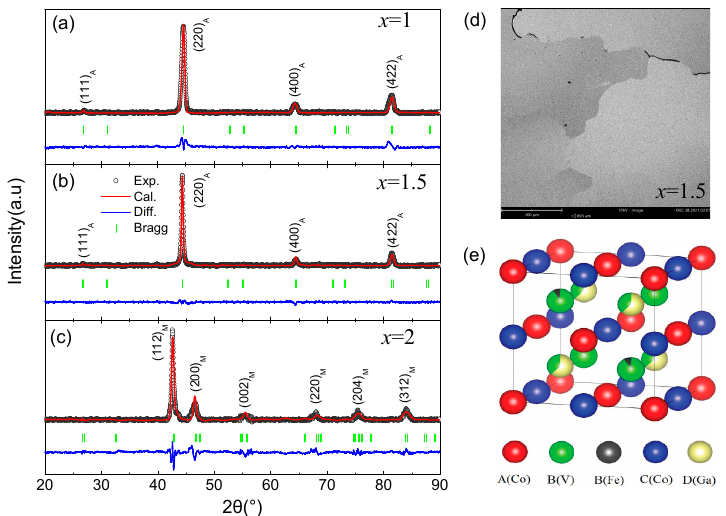
Figure 1. ( a – c ) The X-ray diffraction patterns of Co 50 V 34 Ga 16- x Fe x alloys at room temperature. ( d ) The micrograph taken by SEM for the sample with x = 1.5. ( e ) The L 2 1 -type Heusler structure, which consists of four interpenetrating fcc sublattices.